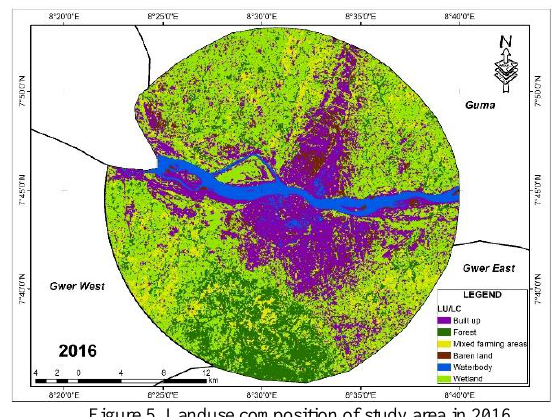
Figure 5. Landuse composition of study area in 2016.